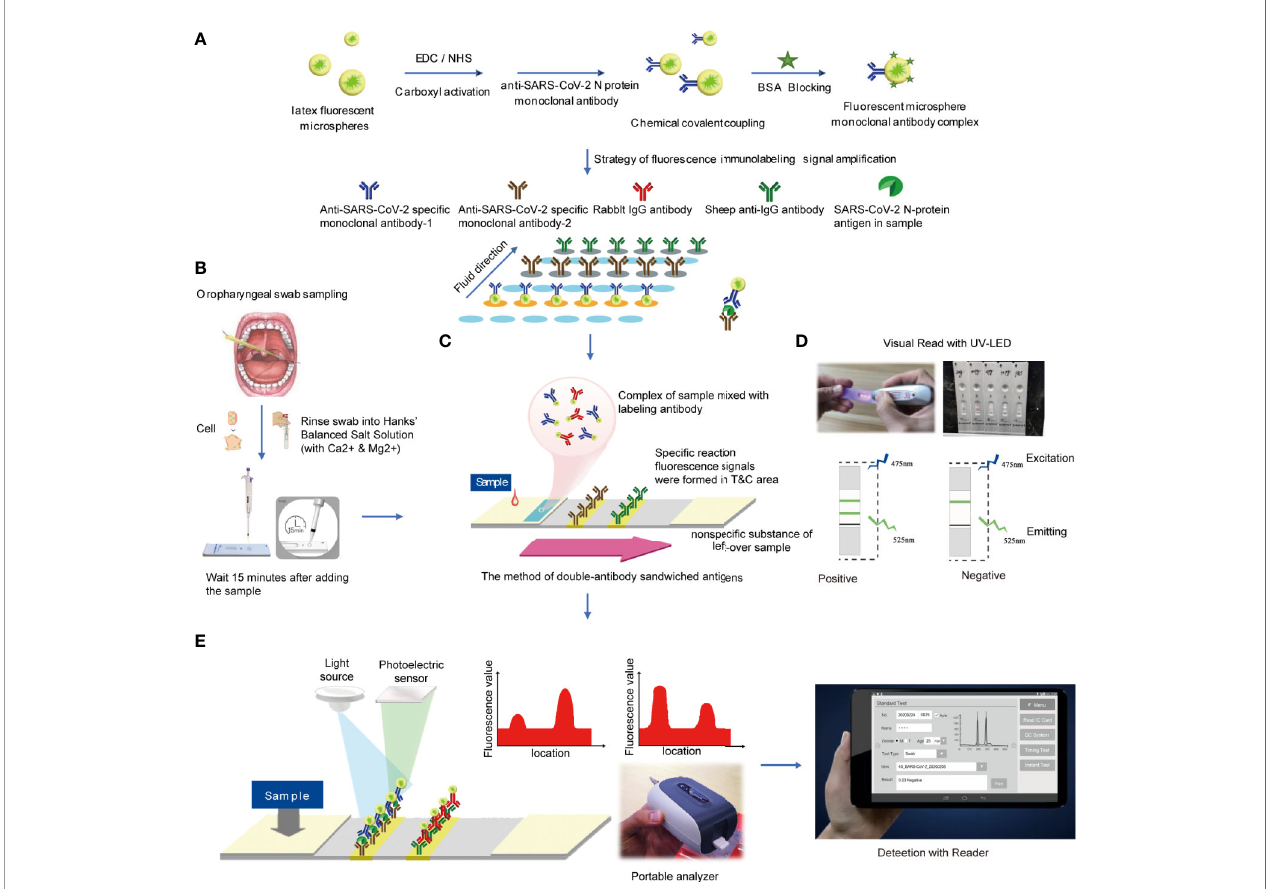
FIGURE 2 | Reagent preparation and detection process (A) . Preparation of antibody detection reagent strip (B) . Oropharyngeal swab sampling (C) . The method of double-antibody sandwiched antigens (D) . Read the result using UV-LED (E) . Analyzed by the